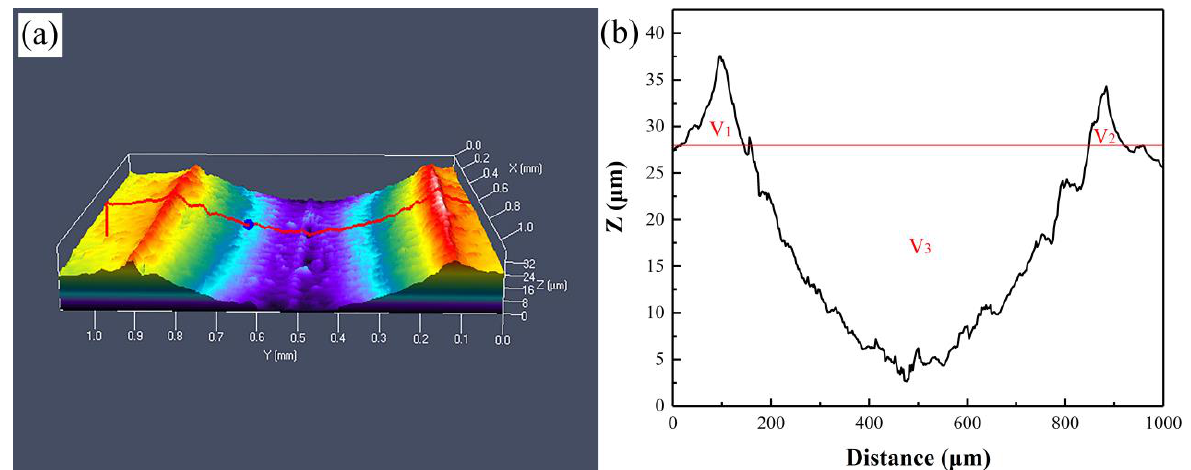
Figure 3. Three-dimensional profiles of ( a ) wear surfaces and ( b ) the roughness change curve of composites.